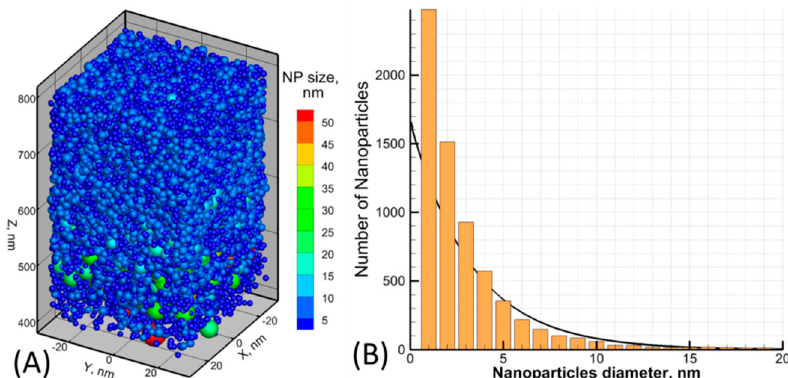
Figure 8. The NPs formed due to 0.3 ps laser pulse interaction with a thick Au target are shown for the area “2” in Figure 7B between 400 nm and 800 nm of the ablation plume ( A ). The NPs are colored and sized in accordance to their diameter value. The NPs size distribution for the same conditions is shown in ( B ). The exponential fit is applied for estimation of the NPs mean size of ~3–4 nm.